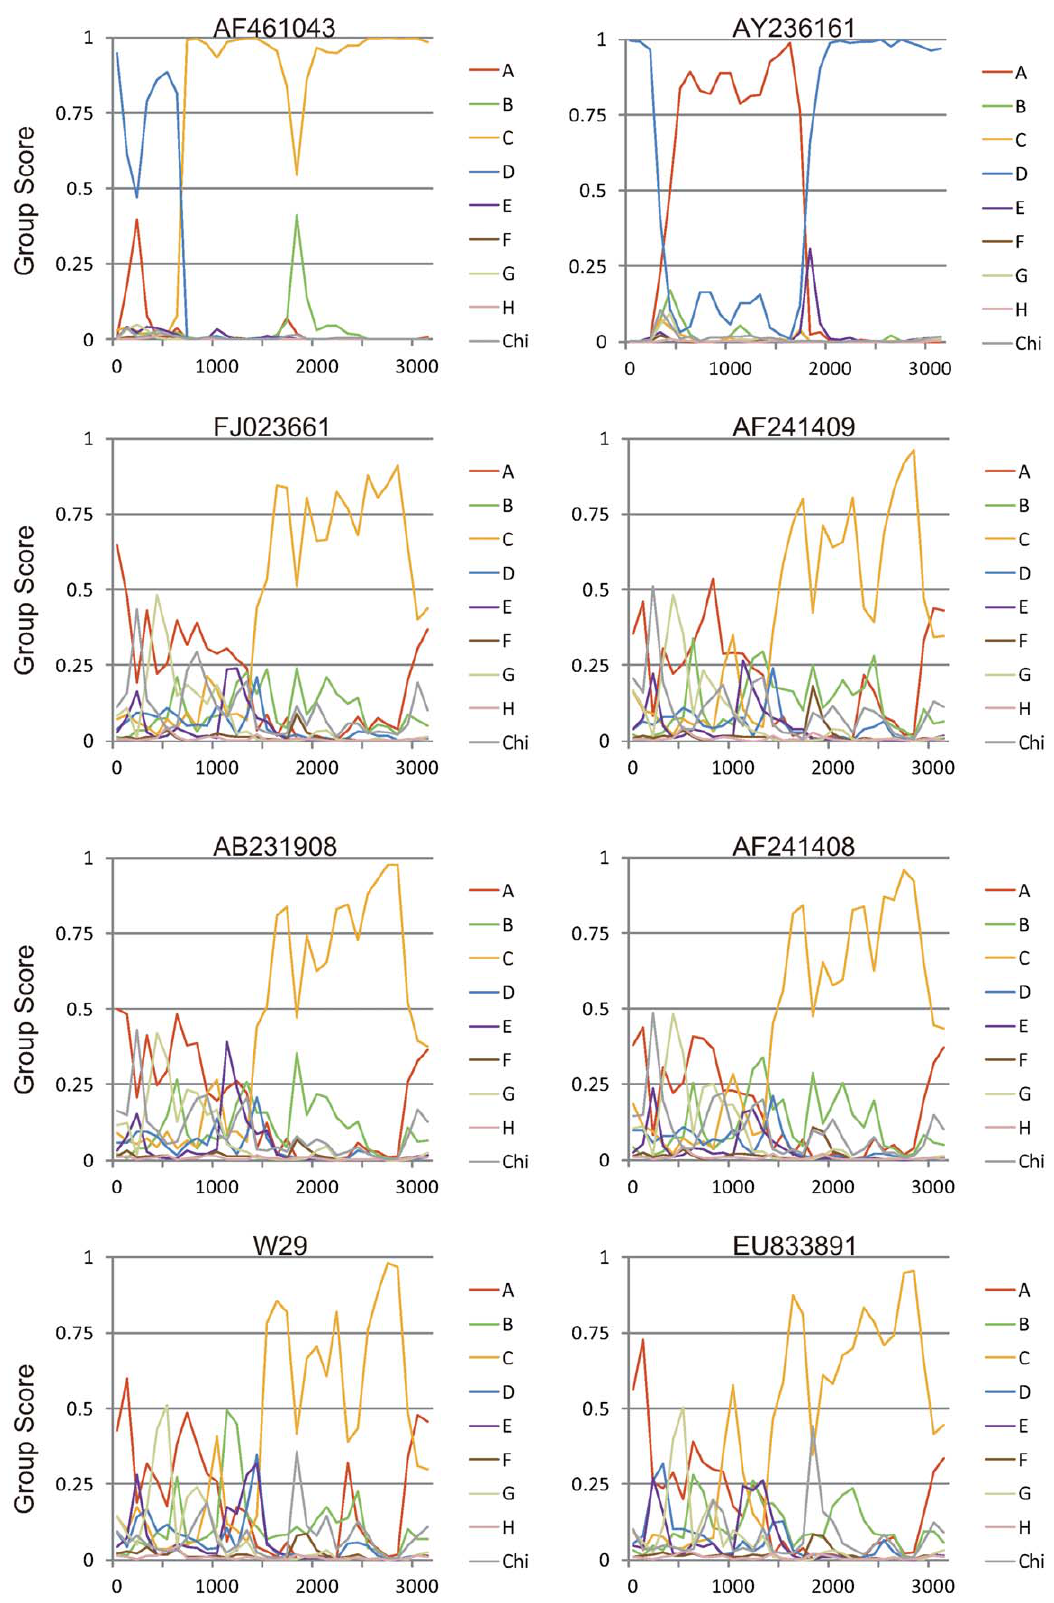
Figure 3. Group Scan Analysis. Eight HBV strains were submitted to Group Scan program and calculated against the reference groups of nonrecombinant HBV sequences from human genotypes A to H and nonhuman ape-derived variants ( n =322) [18].